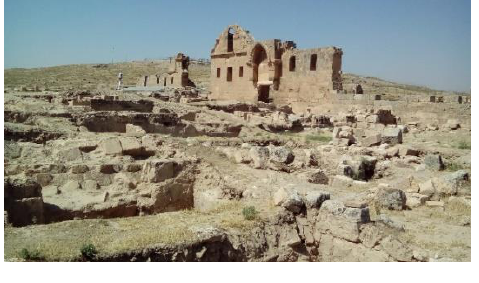
Figure 1. Study area Excavation work in the Harran region continues